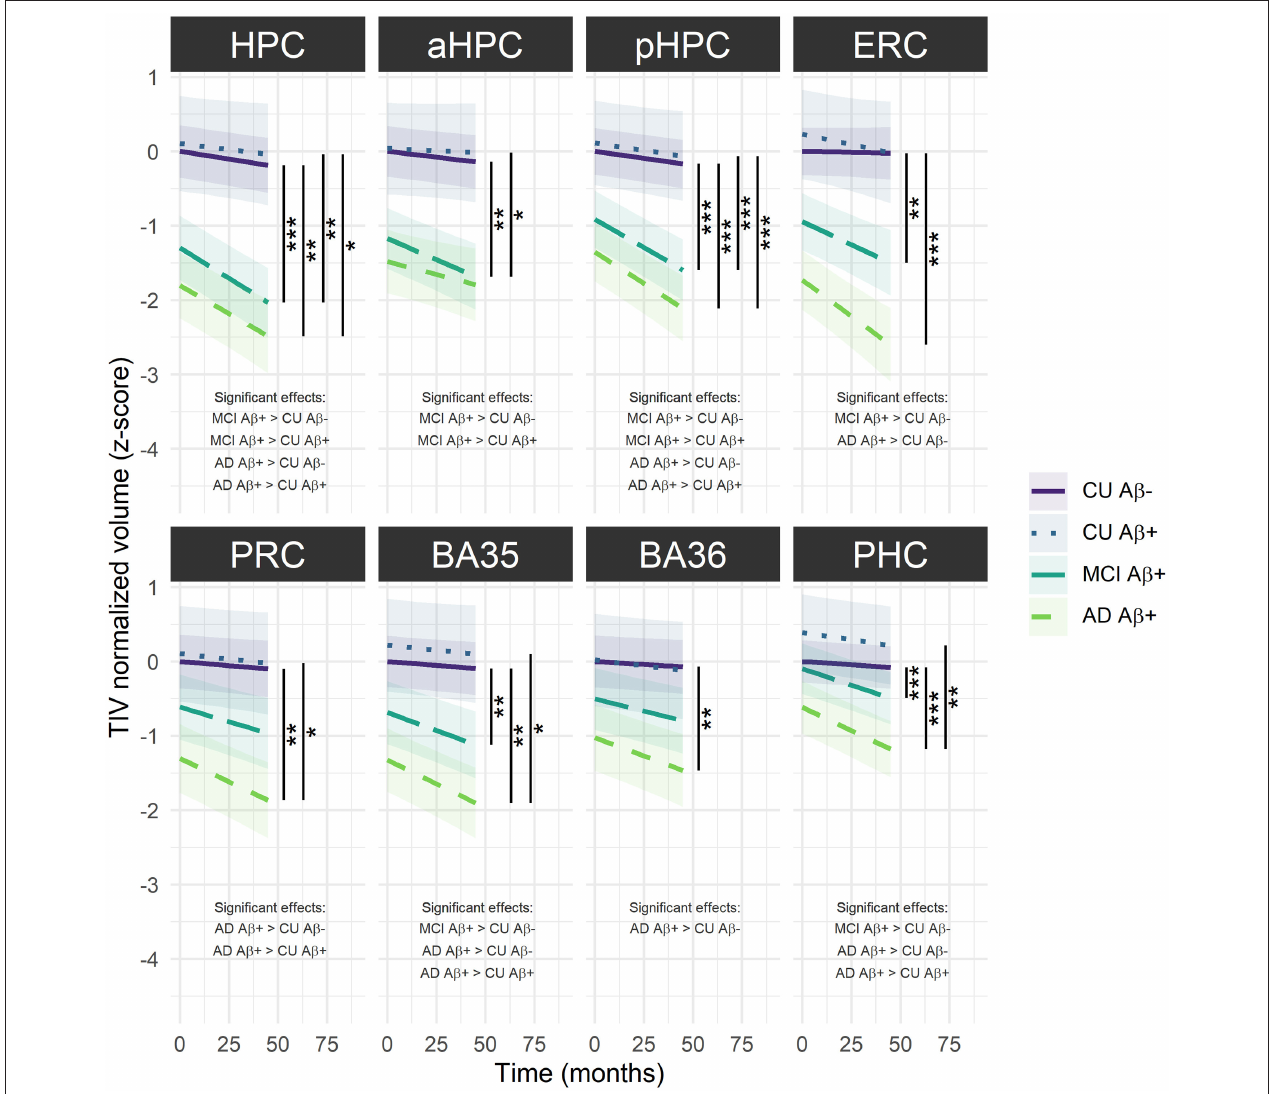
FIGURE 3 | Group comparisons of MTL subregions volume decline over time across the Alzheimer’s continuum. The regression line indicates model-derived estimates. The shaded area represents a 95% confidence interval. *** p < 0.001; ** p < 0.01; * p < 0.05, as results of Tukey adjusted post-hoc t -tests. AD,